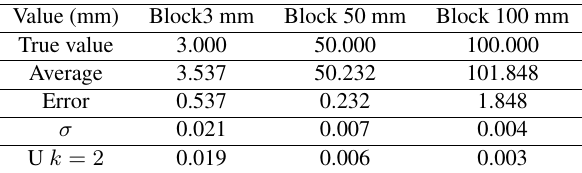
Figure 4. Active Stereoscopic Technique setup and measurement. Table 3. Results of active stereoscopy technique.